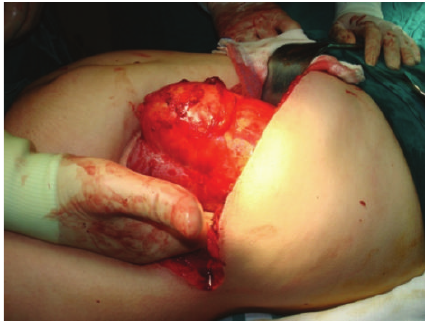
Figure 2: Access to the left kidney through flank approach.